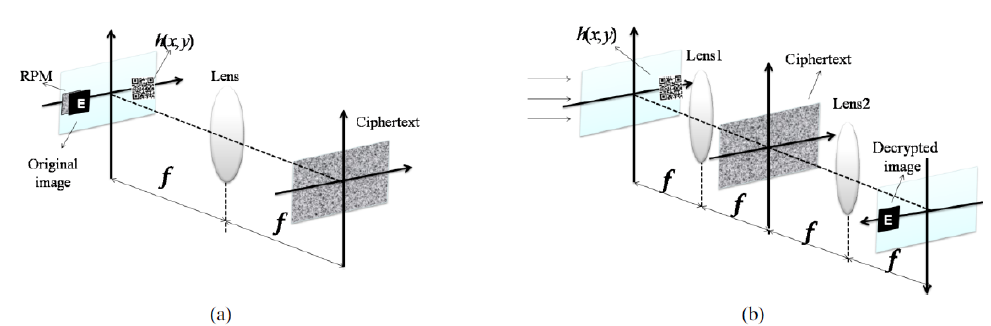
Figure 2. The scheme of a cryptosystem based on JTC. Figures ( a , b ) present the encryption and decryption processes, respectively